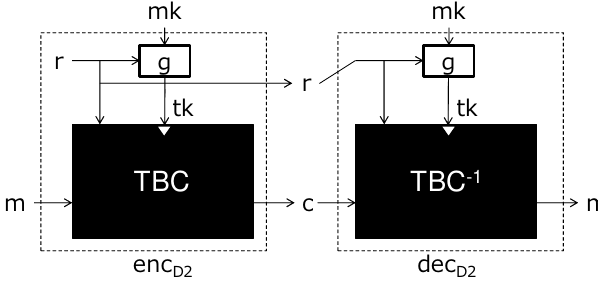
Figure 9. Dobraunig et al.’s second re-keying scheme (generic